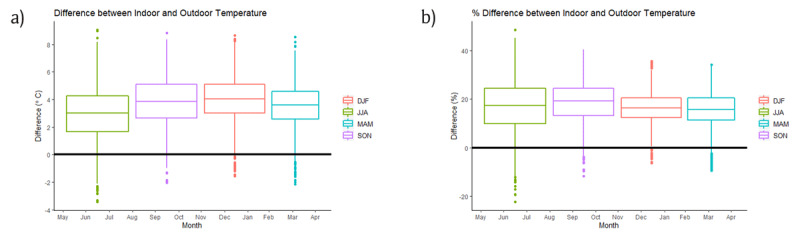
Boxplots of the difference between indoor and outdoor temperatures: Line represents the median, whiskers represent scores outside the middle 50%, box length represents interquartile range. (a) Temperature difference represented in degrees Celsius (b) Temperature difference represented as a percentage of indoor temperature.(Note: Summer DJF: December, January, February = summer; Winter JJA: June, July, August = winter; Autumn MAM: March, April, May = autumn; Spring SON: September, October, November = spring).